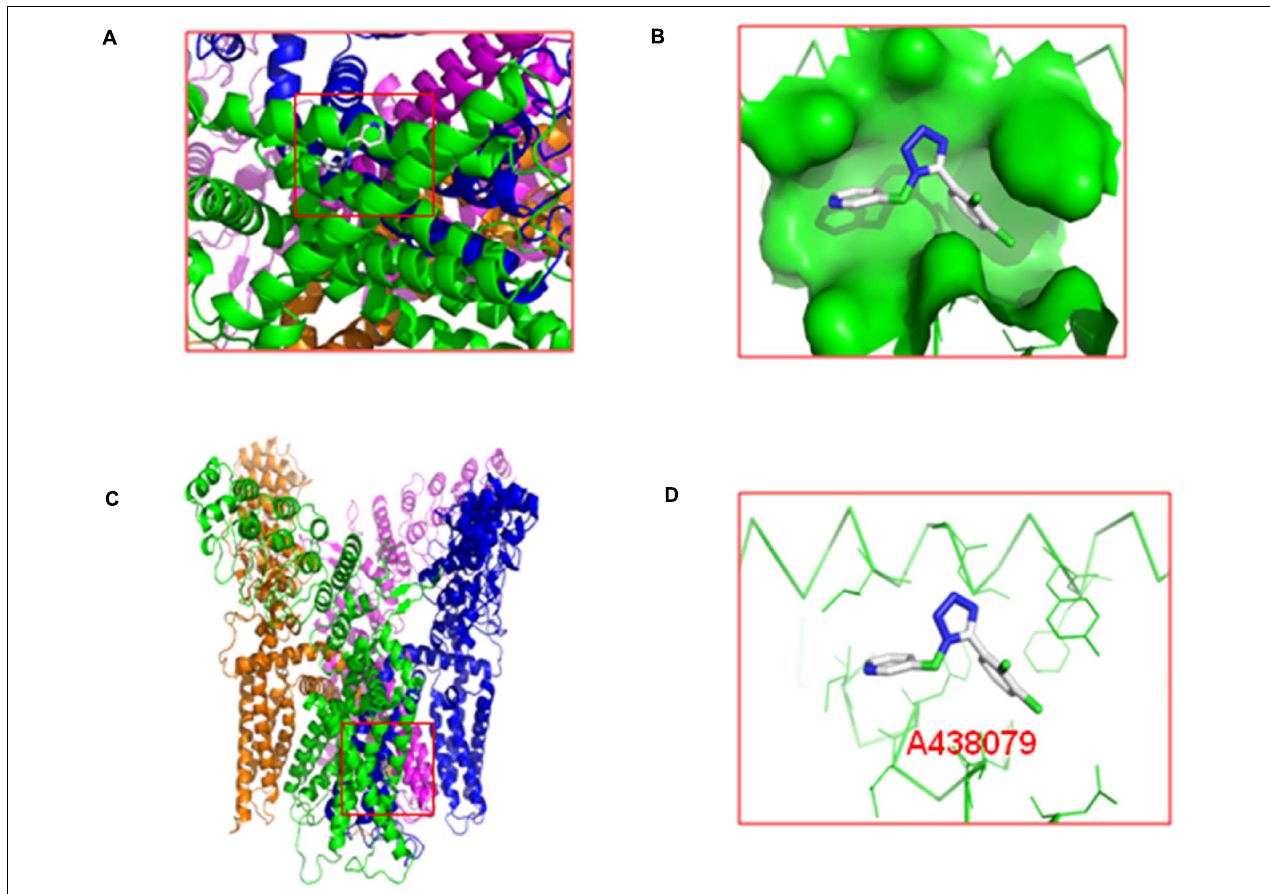
FIGURE 6 | Molecular docking of A438079 with the TRPV1. (A) , top view. (B) , the docking pocket between A438079 and TRPV1. (C) , front view. (D) , A438079 does not form a hydrogen bond with TRPV1, and A438079 is in the